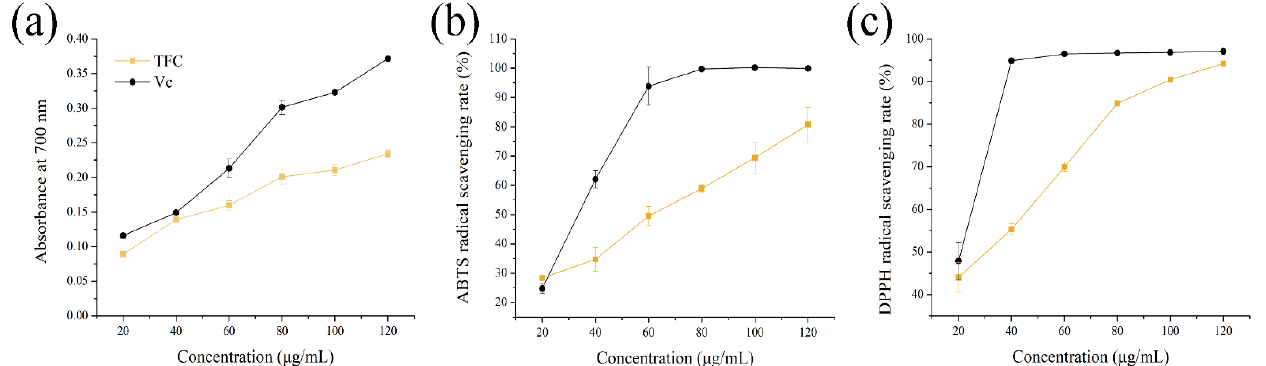
Figure 2. Antioxidant activities of TFC in vitro: ( a ) reducing power, ( b ) ABTS+ scavenging activities